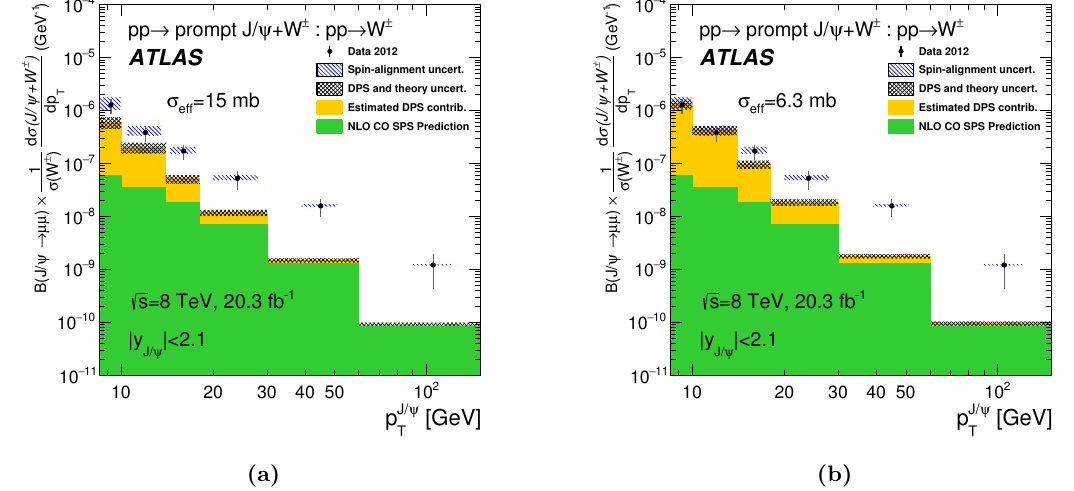
Figure 3. The inclusive (SPS+DPS) di(cid:11)erential cross-section ratio measurements and theory pre- dictions presented in six p J= regions for j y j < 2 : 1. NLO colour-octet SPS predictions are shown, J= T with LDMEs extracted from the di(cid:11)erential cross-section and spin alignment of prompt J= mesons at the Tevatron [13, 14]. The DPS contribution is estimated using (a) (cid:27) e(cid:11) = 15 +5 : 8 mb and (b) (cid:27) e(cid:11) = (cid:0) 4 : 2